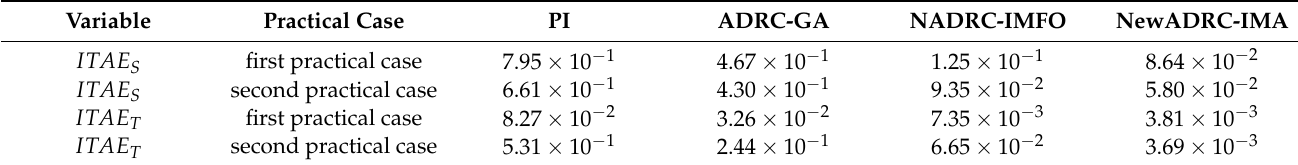
Table 1. The speed and torque ITAE for each practical case.